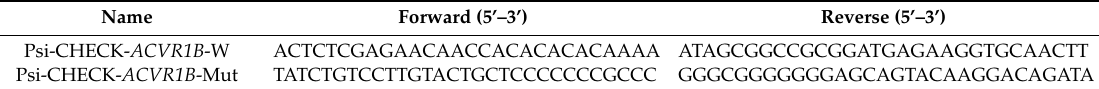
Table 2. Primers used for vector